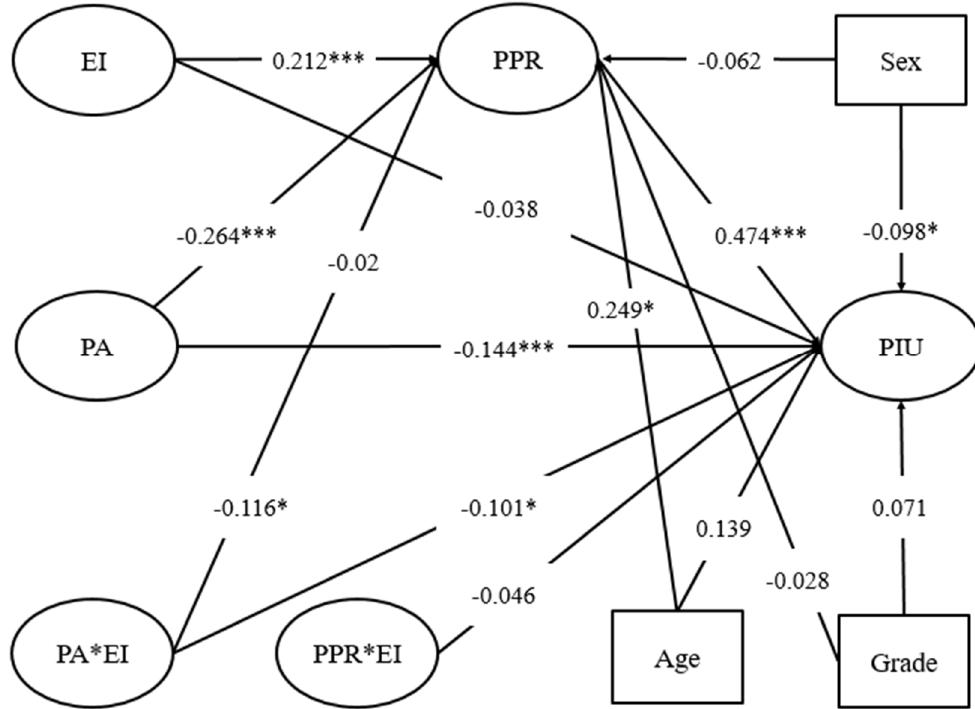
Figure 2. The mediating effect of perceived personal rejection on the relationship between peer attachment and pathological Internet use. PA = peer attachment, PPR = perceived personal rejection, EI = emotional intelligence, PIU = pathological Internet use. * p < 0.05, *** p < 0.001.